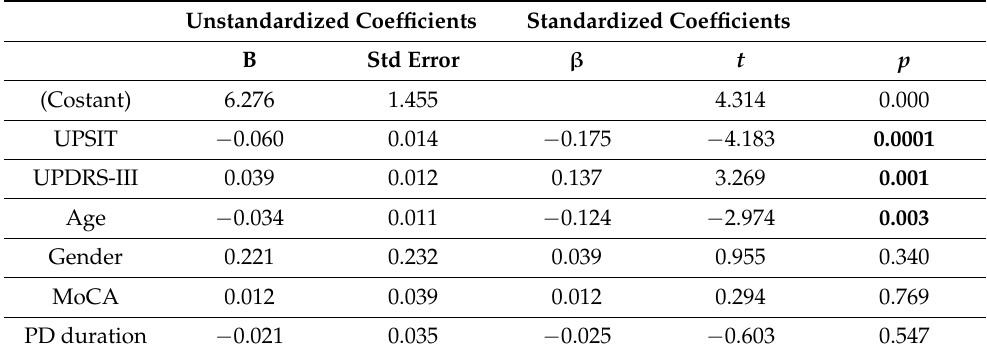
RBDSQ = Rapid Eye Movement Sleep Behavior Disorder Screening Questionnaire; UPDRS-III = Uni- fied Parkinson’s disease rating scale part III; MoCA = Montreal Cognitive Assessment; UPSIT = Uni- versity of Pennsylvania Smell Identification Test; PD = Parkinson’ s disease; Std Error: Standard error of the mean. Significant p values are highlighted in bold. Multivariate linear regression analysis showed that the mean value of the UPSIT test (Figure 1A), which indicated the olfactory function of the patients, was the most signifi- cant predictor for higher scores in the RBDSQ [F (6,589) = 6.634, p < 0.0001], while other sig- nificant predictors were UPDRS-III (Figure 1B) and age ( p < 0.001 and p < 0.003, respec-